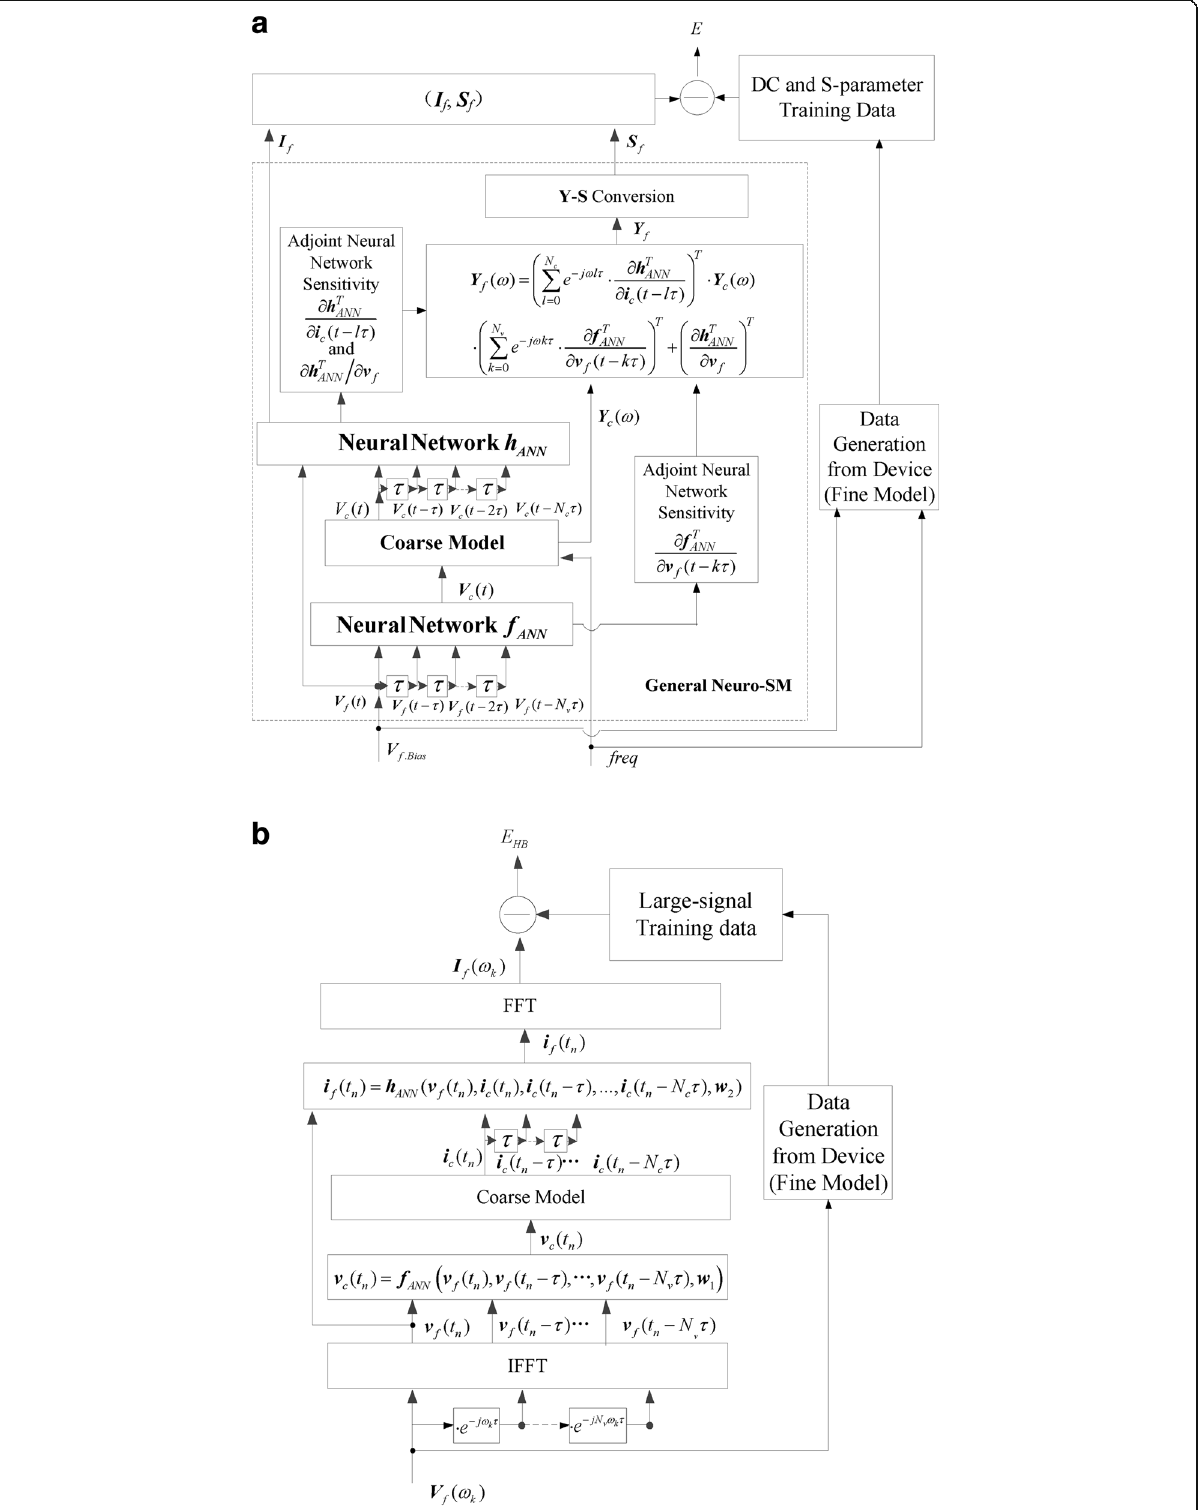
Fig. 2 Block diagram for error calculation of the general Neuro-SM model. a Error calculation for combined dc and small-signal S parameter train- ing. b Error calculation for large-signal HB